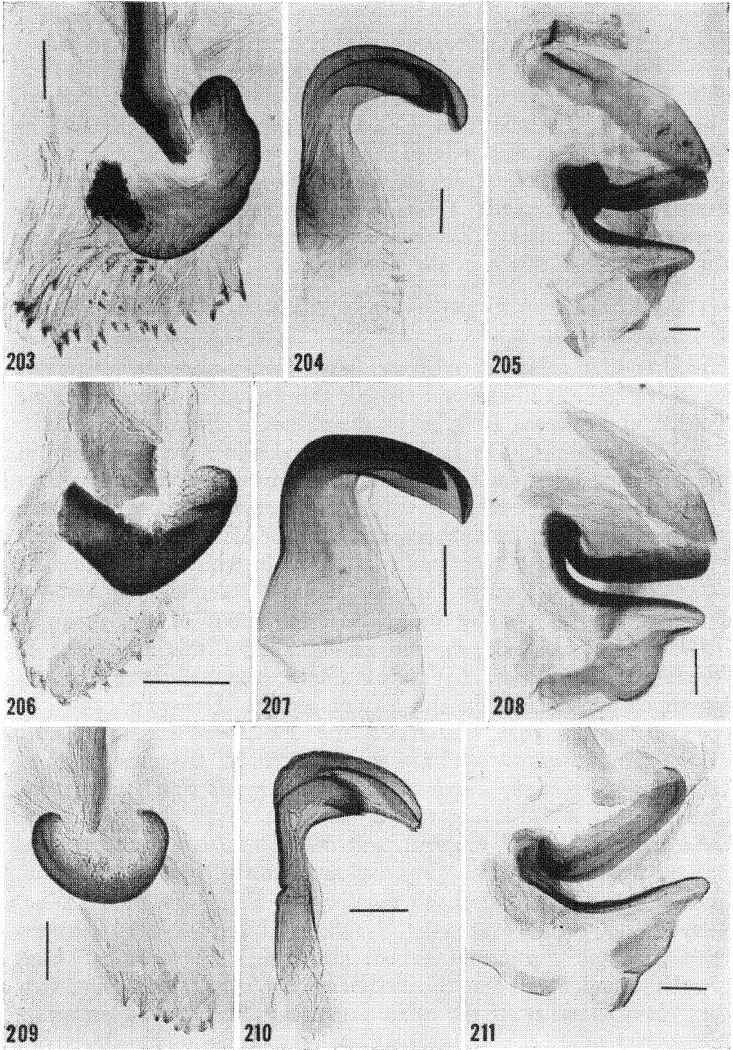
Figs. 203-211. 203-205. (962 L). Parahormetica cicatricosa. (from speci- men shown in Fig. 172). 206-208. (972 L). Oxycercus lberuianus. (from specimen shown in Fig. 173). 209-211. (49 USNM). Bionoblatta itatiayae. (from specimen shown in Fig. 174). (scale 0.3